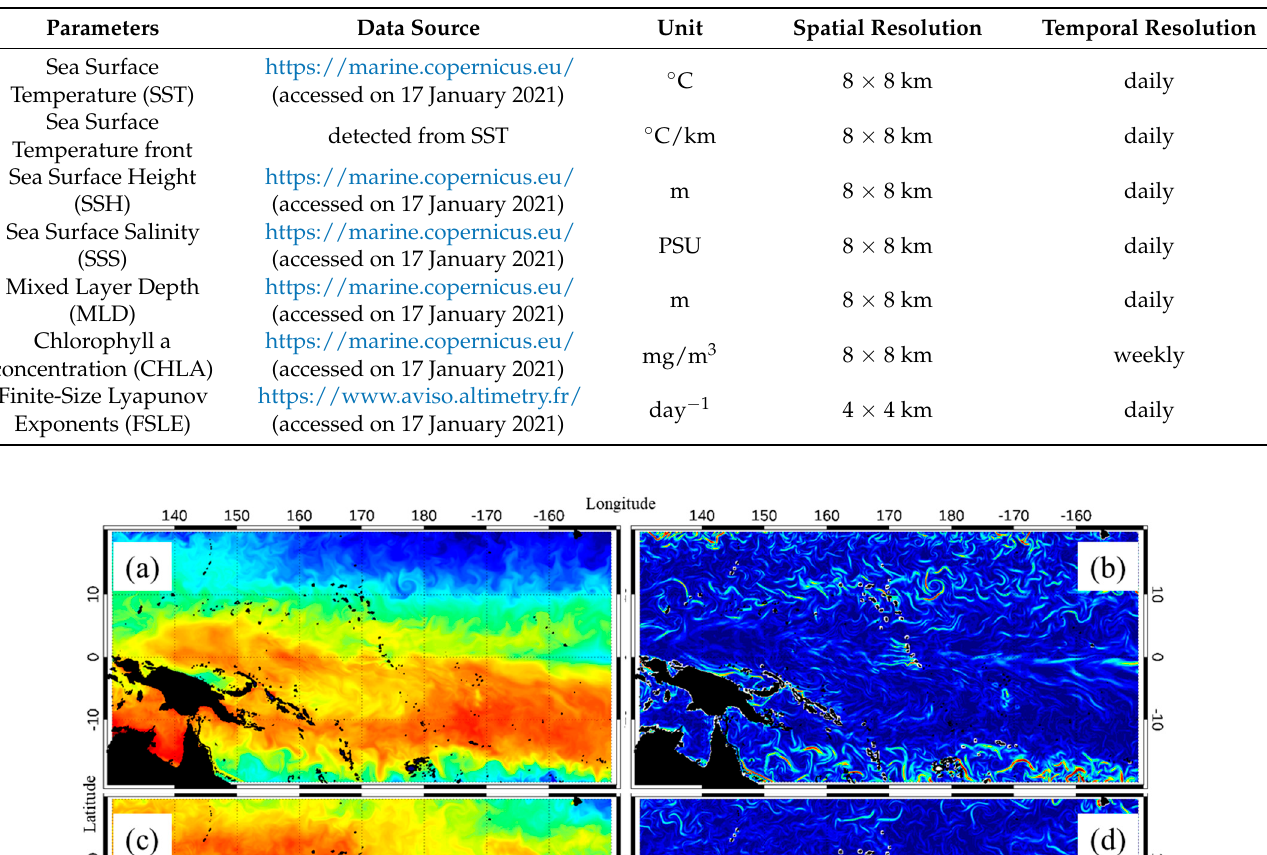
Table 1. List of satellite remote sensing data and the data sources.